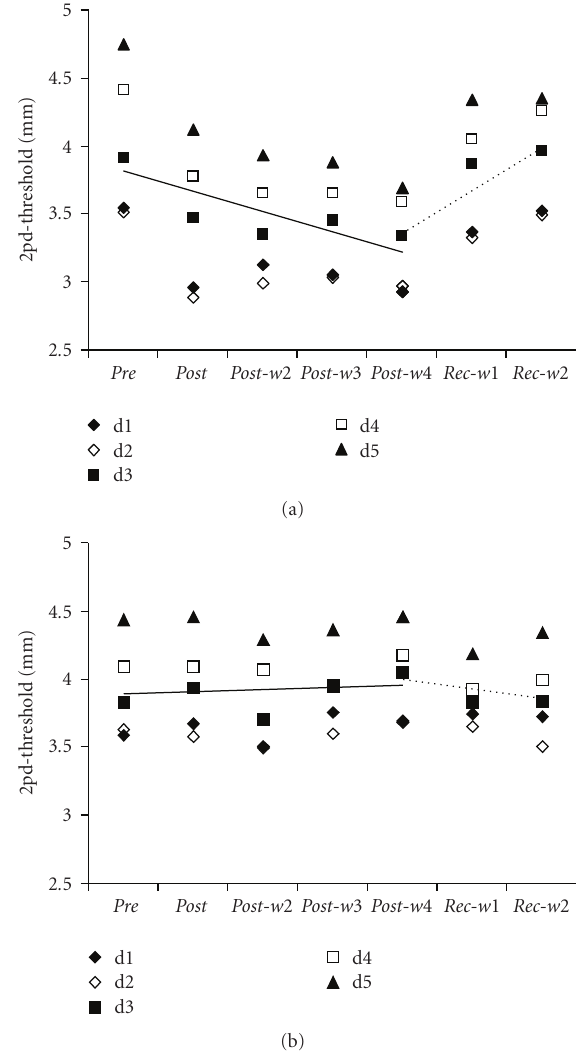
Figure 1: (a) Time course of the performance in the two-point discrimination (2pd) test. Two-point discrimination thresholds of all fingers of the dominant hand (d1 = thumb; d5 = little finger) averaged across subjects of the target group as obtained before (pre), during (post-w2–post-w4) and after the rES (rec-w1–rec- w2). There was a significant decrease in thresholds from pre session to post-w4 (Spearman correlation r ≥ − 0 . 404, P ≤ . 033), followed by a recovery of thresholds from post-w4 to rec-w2 ( r ≥ 0 . 581, P ≤ . 001) . Solid line gives the linear regression for average thresholds of d1–d5 from pre session to post-w4 and dashed line gives the linear regression from post-w4 to rec-w2. (b) Same as (a) for the subjects of the control group, who received sham stimulation instead of